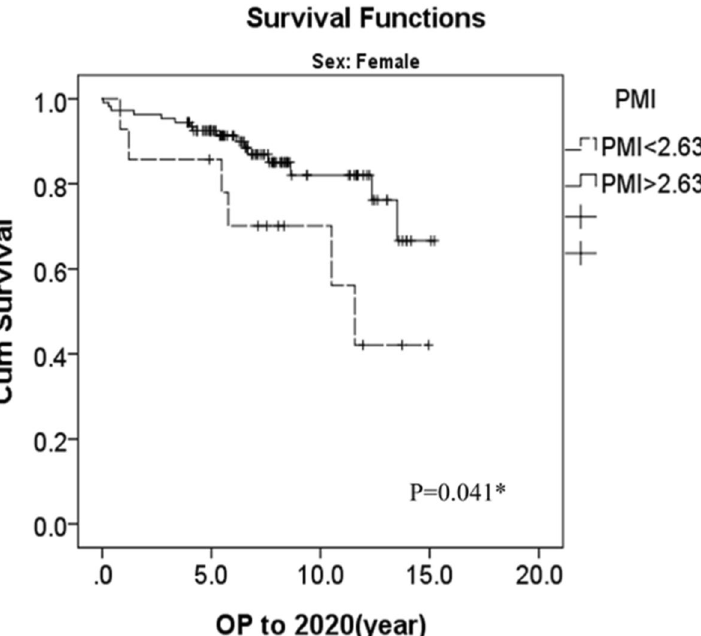
Figure 3. Survival analysis by Kaplan–Meier method.